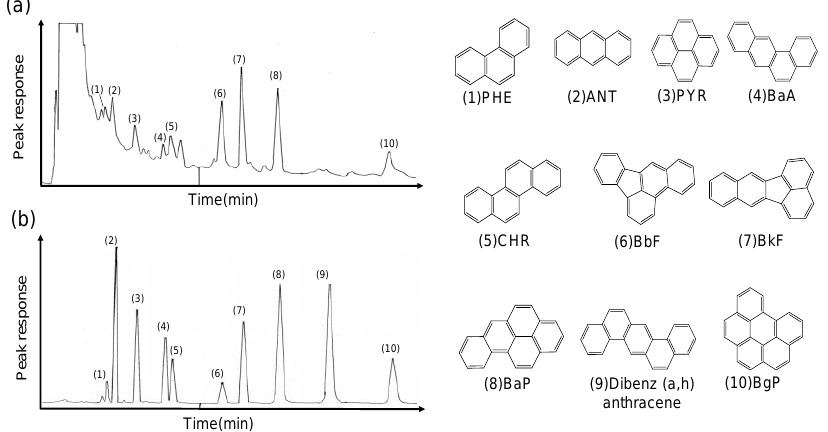
Figure 8. Typical high-performance liquid chromatography (HPLC) chromatograms of ( a ) extracts from PM 2.5 before UV-irradiation and ( b ) standard solution at a dilution ratio of 10,000 times.